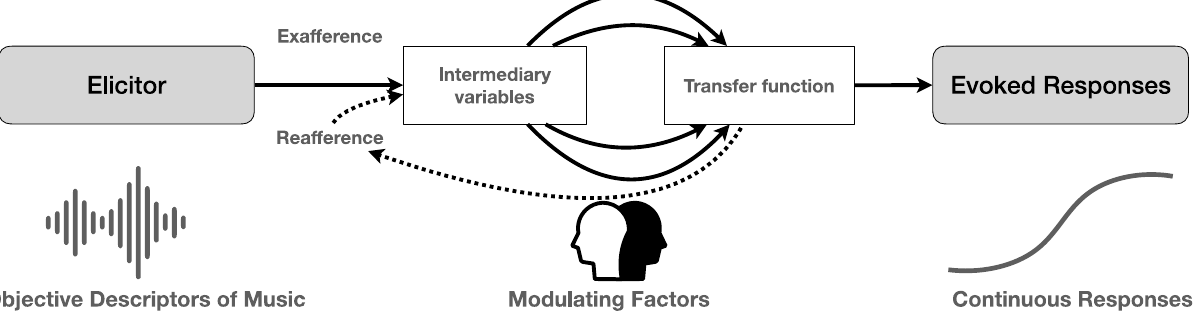
Figure 2. Overview of the elicitor–response schematic with dual input from self-generated (reaffer- ence) and externally generated (exafference) sources.